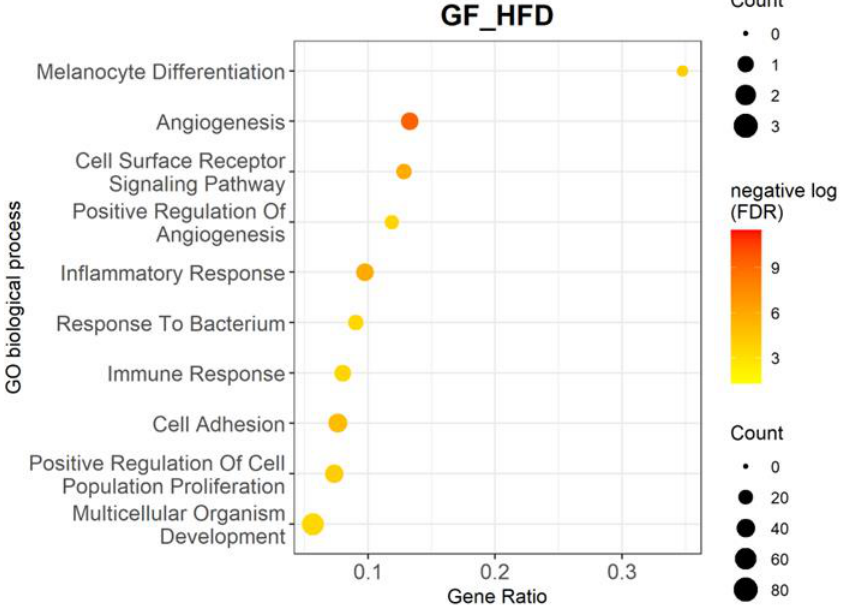
Figure 2. Enrichment analysis of DEGs between GF-HFD mice ( n = 4) and GF-ND mice ( n = 4) using Lynx. Gene ontology analysis is shown for top 10 biological processes upregulated in GF-HFD mice compared to GF-ND mice, highlighting pathways including the angiogenic, inflammatory, and immune responses. The corresponding table demonstrates detailed statistics and genes involved in these processes. Table 3. Top 10 molecular pathways upregulated by high-fat diet